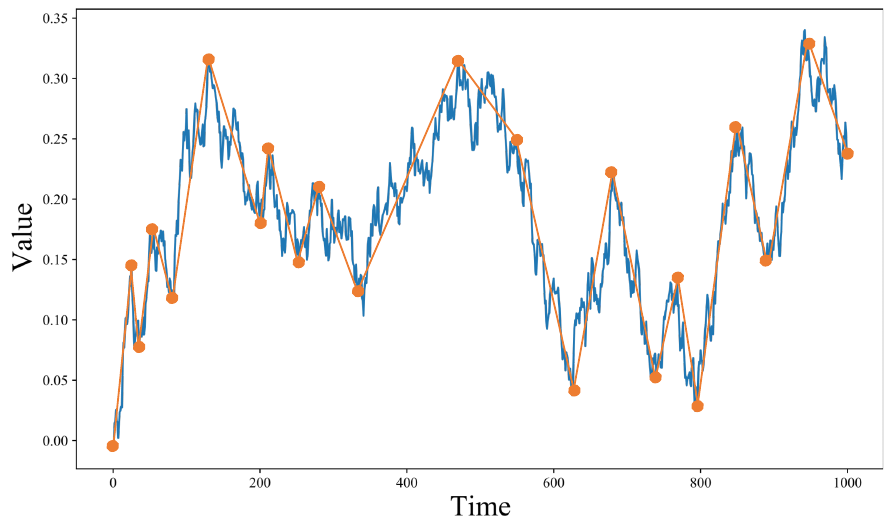
Figure 1. An illustrative example of the time series segmentation target, where the blue line represents the raw time series, and the orange one represents the new time series representation generated by ASAR [19].